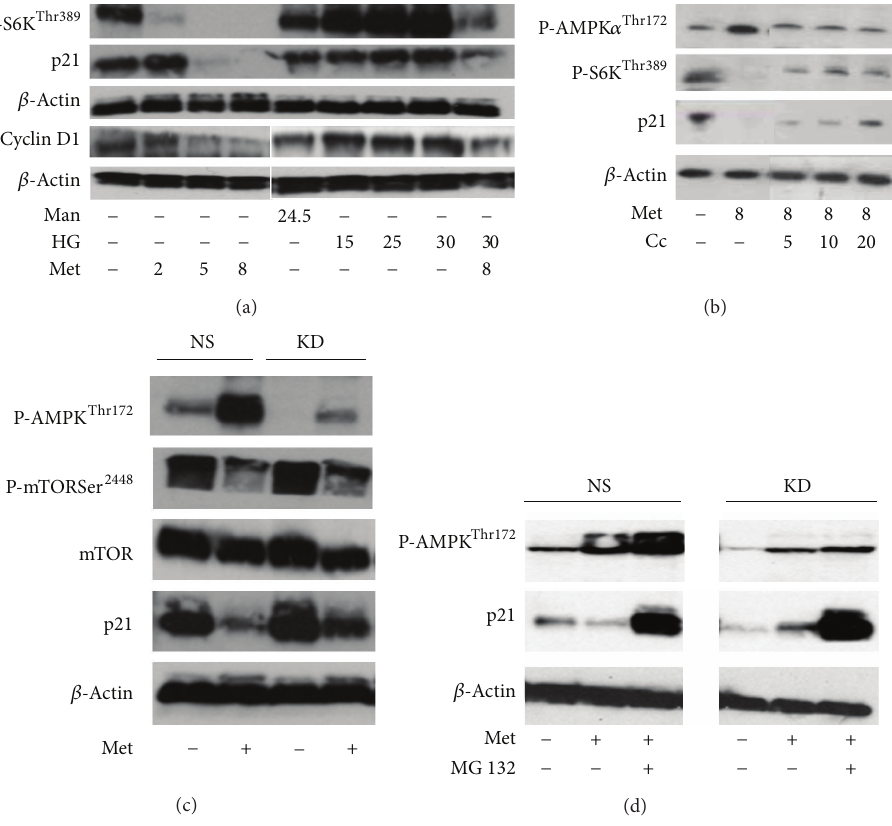
Figure 6: Western blot results indicate that AMPK inhibition is associated with the reversal of metformin-induced p21 downregulation in HEK293 cells. In these experiments, the protein level of P-S 6 K Thr 389 , cyclin D1, P-AMPK 𝛼12 Thr 172 , and P-mTOR Ser 2448 was measured in order to confirm the expected effects of treatments. mTOR and 𝛽 -actin were used to control equal protein loading. (a) The cells were treated with culturemediumcontaining5.5 mMD-glucose.Mannitol(Man)andD-glucose(HG)wereaddedforthreedaysattheindicatedconcentrations (mM). The cells were treated with metformin (Met) for 24 h at the indicated concentrations (mM). (b) Compound C (Cc) reverses metformin- induced p21 downregulation. The cells were treated with Met and Cc for 24 h at the indicated concentrations (mM and 𝜇 M, resp.). (c) HEK293 cells stably transfected with shRNA expression plasmids targeting AMPK 𝛼 2 (KD) or nonsilencing (NS) were cultured with or without 8 mM metformin for 18 h in whole cell culture medium. (d) The proteasome inhibitor carbobenzoxy-Leu-Leu-leucinal (MG132) prevents metformin-induced (Met) downregulation of p21. HEK293 cells stably transfected with shRNA expression plasmids targeting AMPK 𝛼 2 (KD) or nonsilencing (NS) were cultured with or without 8mM metformin and 10 𝜇 M MG132 overnight in whole cell culture medium. Vehicle effects were controlled by adding 0.05% DMSO to the